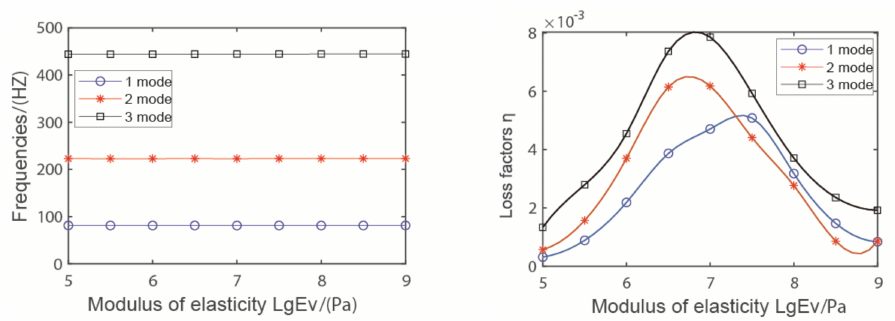
Figure 8. The effect of the modulus of elasticity of the viscoelastic layer.